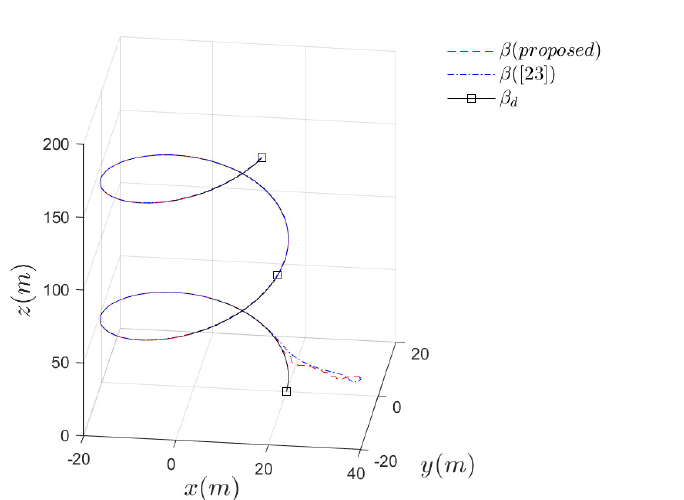
Figure 8. Comparison of tracking results of the proposed approach and the previous approach [23] in three-dimensional space for Scenario 2.